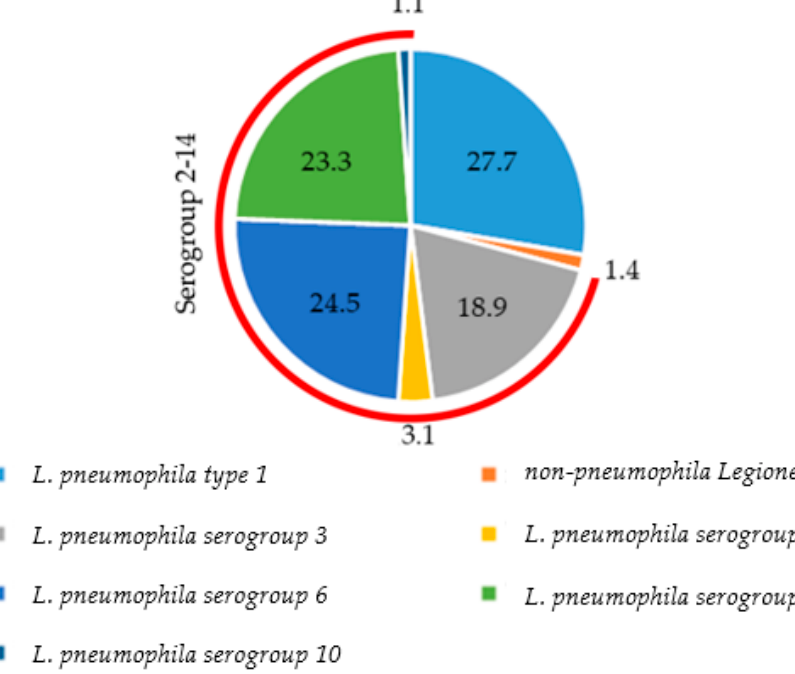
Figure 3. Percentage of positivity of each Legionella species and serogroup during the five-year study period (2018–2022).